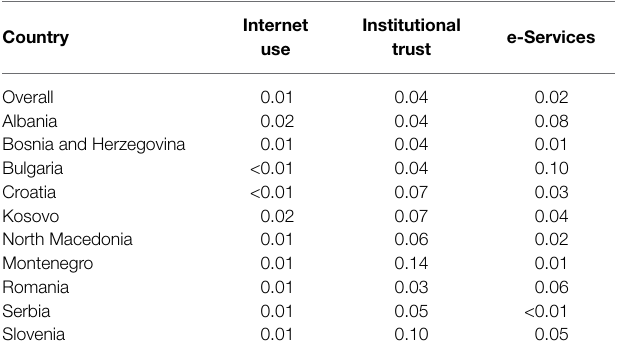
TABLE 2 | Shares of explained variance ( R 2 ) for the endogenous variables in the model.